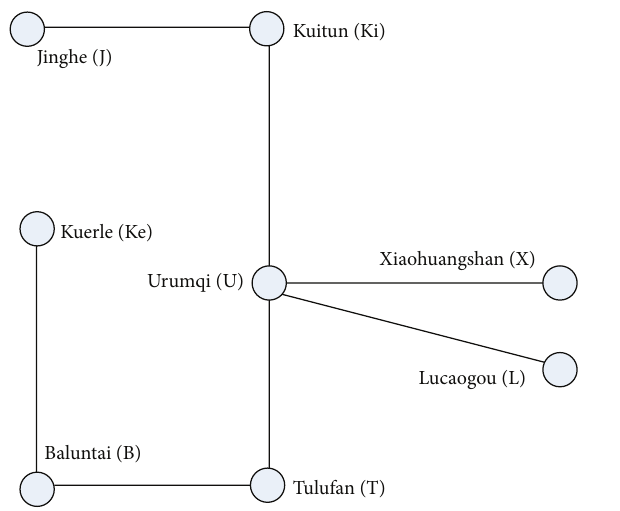
Figure 2: Railway Geographic Network.